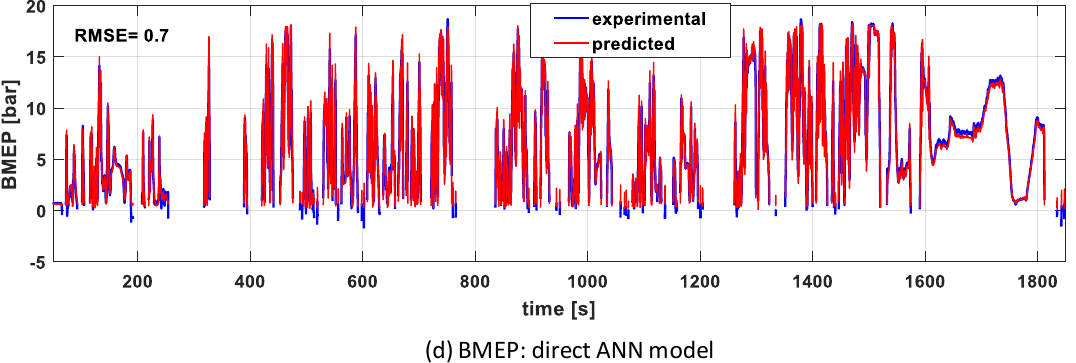
Figure 9. ( a – d ) Comparison of the performance of the developed models over WHTC: BMEP.